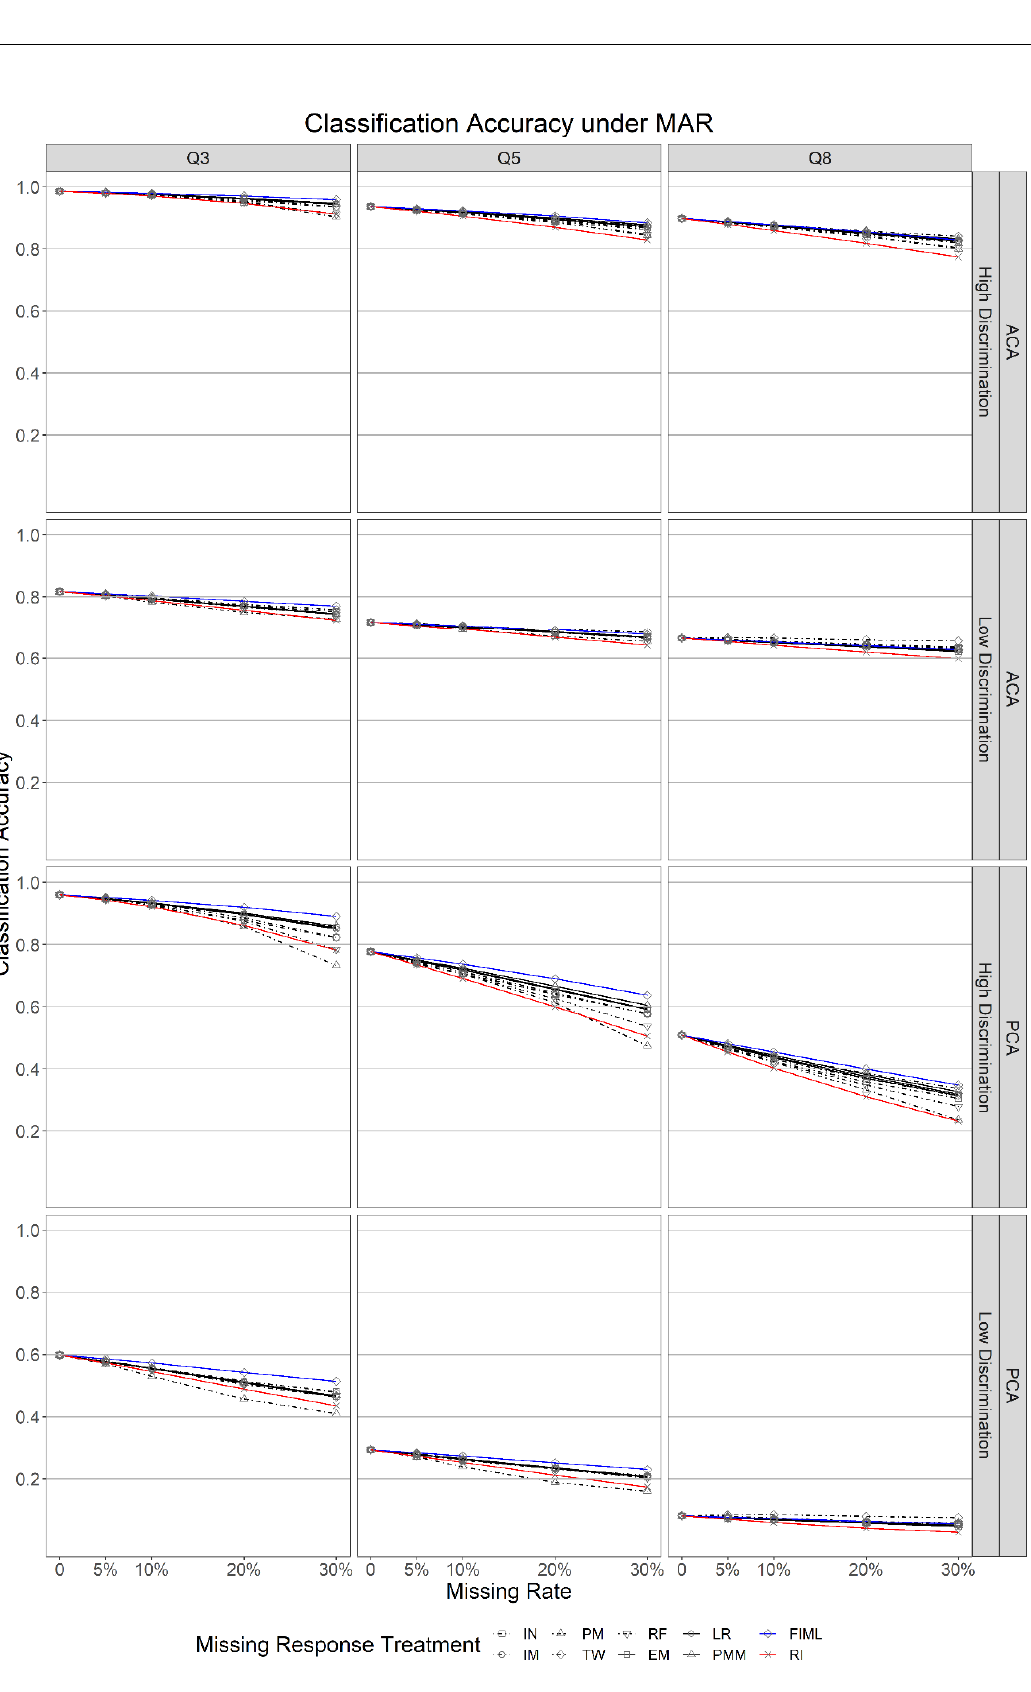
Figure 4. Classification accuracy under the MAR mechanism. Columns Q3, Q5, and Q8 present results for Q-matrices with three, five, and eight attributes, respectively, while rows refer to results across high and low discriminations for both guessing and slipping parameters.